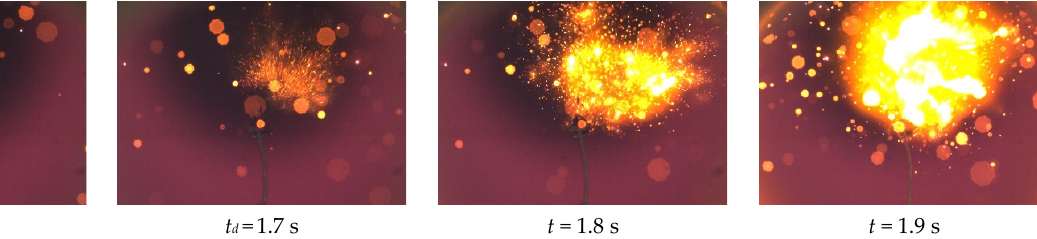
Figure 18. Typical videoframes of ignition and combustion of a particle of gel fuel (composition No. 2—with finely dispersed carbonaceous particles: 70 wt% (50 vol% oil + 48 vol% aqueous solution of PVA + 2 vol% emulsifier) + 30 wt% coal dust) at T g = 900 °C [186].